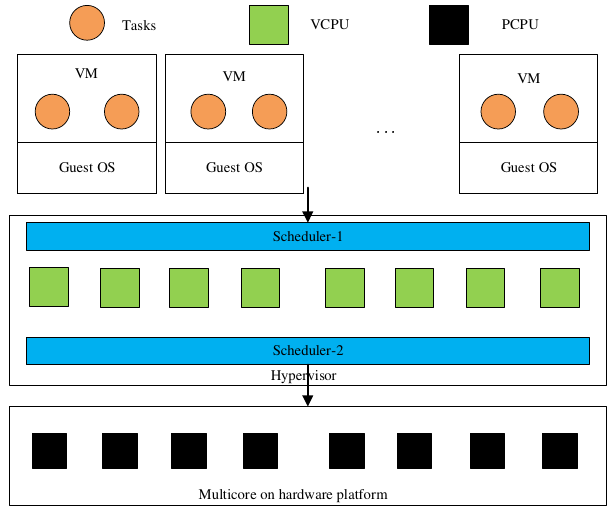
Figure 4. Illustration of Hierarchical scheduling.